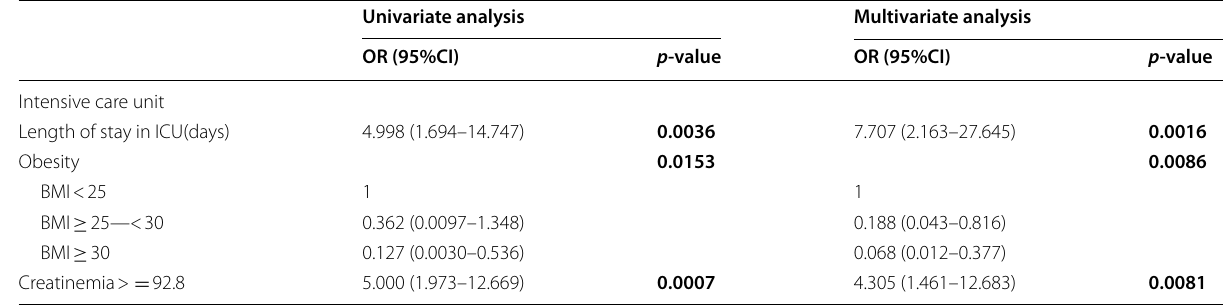
OR odds ratio, CI confidence interval, BMI body mass